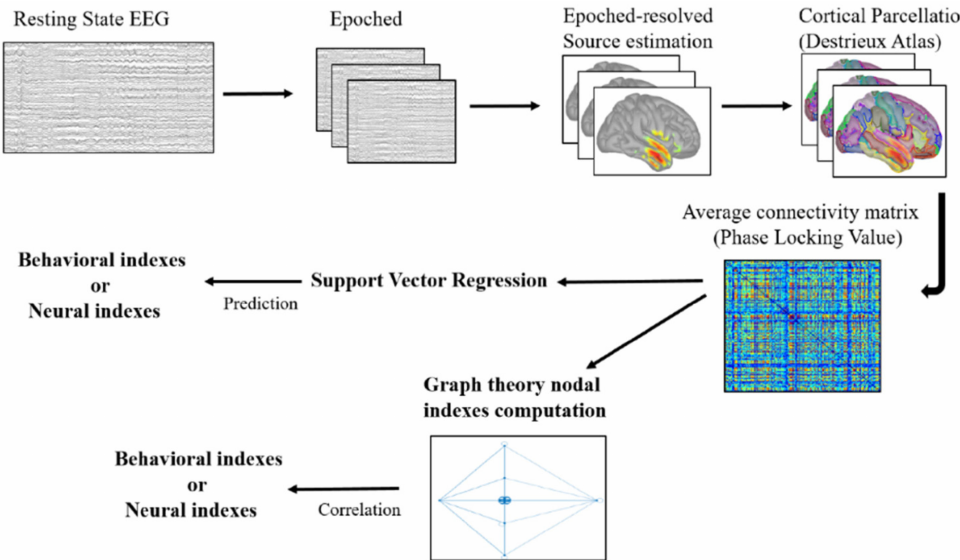
Figure 3. Graphical representation of the analysis pipeline. The present figure illustrates all the computational steps of the analysis pipeline of the present work starting from the resting state electroencephalography